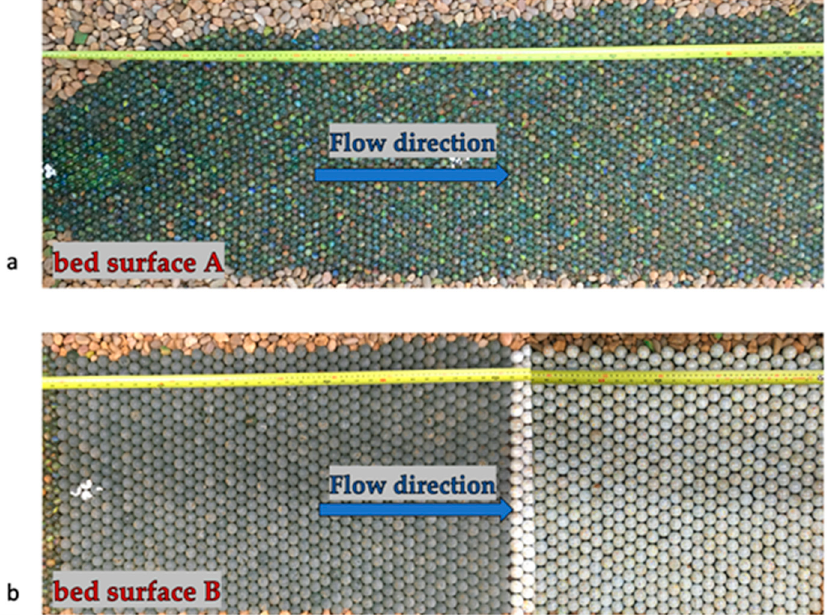
Figure 3. Illustration of the used bed surfaces: ( a ) A and ( b ) B, each comprising of well-packed tetrahedral arrangement of unisize marble beads of 1.5 and 3.15 cm, respectively, resulting in distinct bed surface roughness.